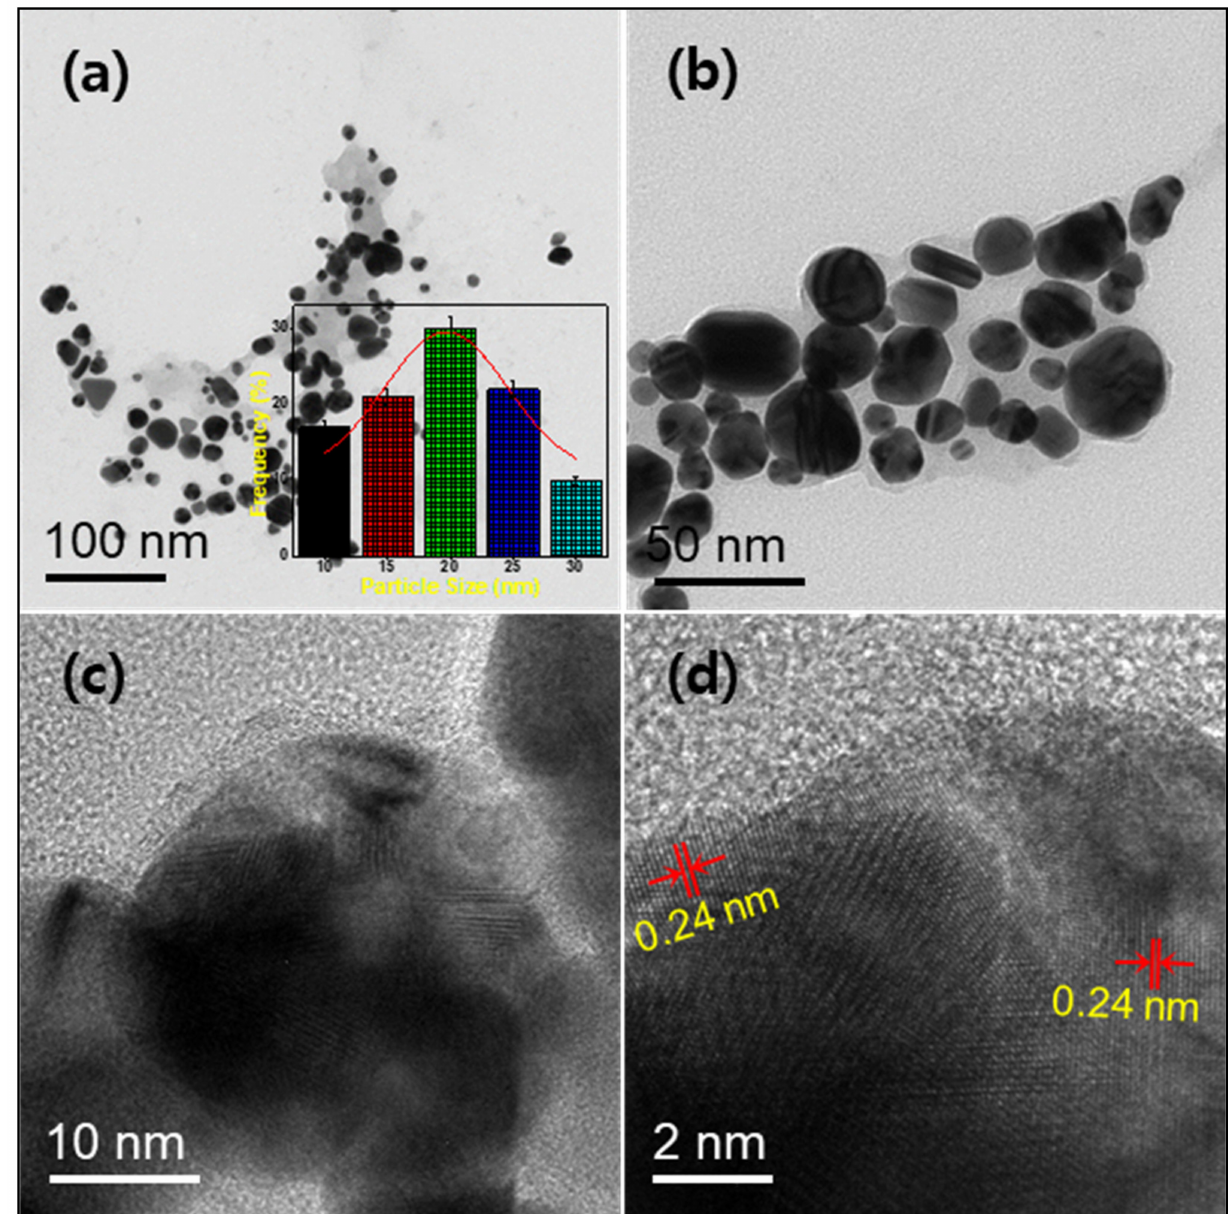
Figure 4. HRTEM images of AgNPs. ( a , b ) TEM images (inset ( a ) is a particle size distribution graph) and ( c , d ) HRTEM images of prepared